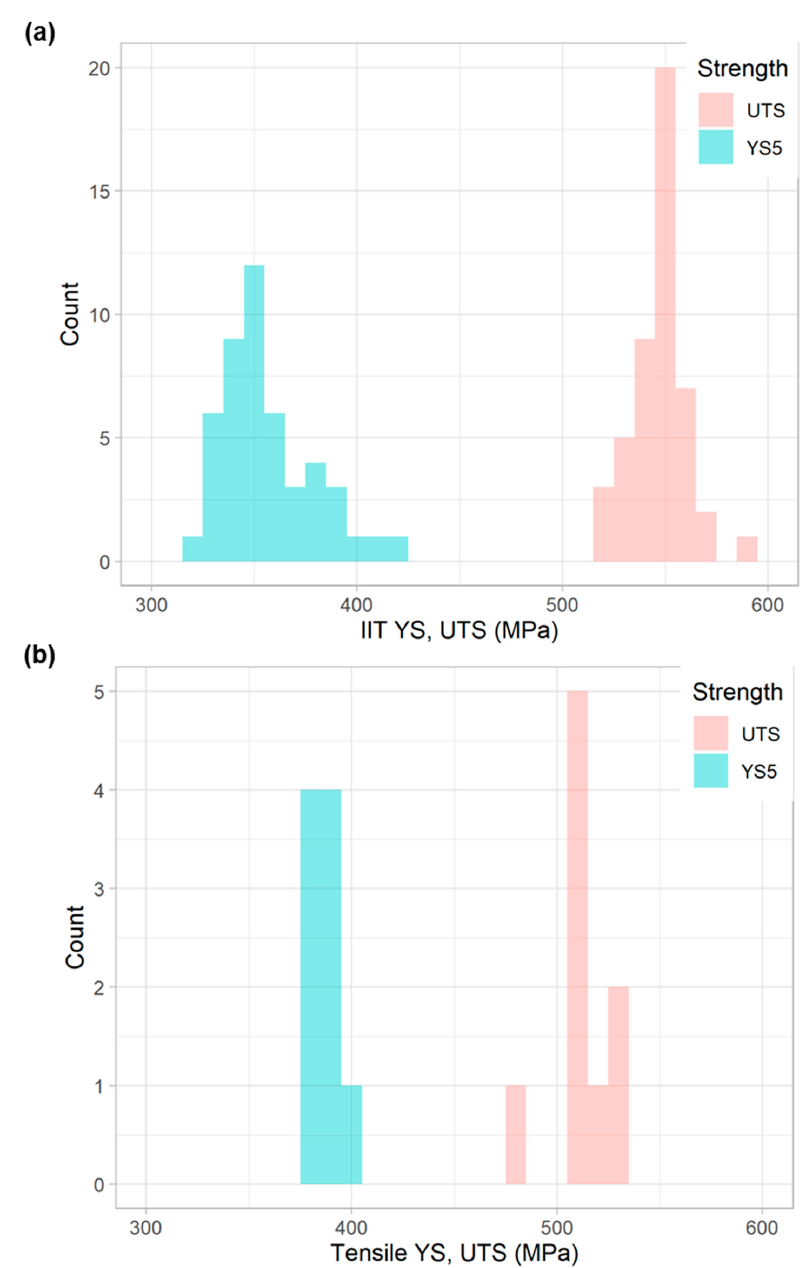
Figure 13. Histogram of YS and UTS for ( a ) IIT and ( b ) tensile measurements performed on the 16-inch (41-cm) OD pipe in the presented example. Table 6. YS and UTS estimates based on the regression models presented in Section 3.3, including